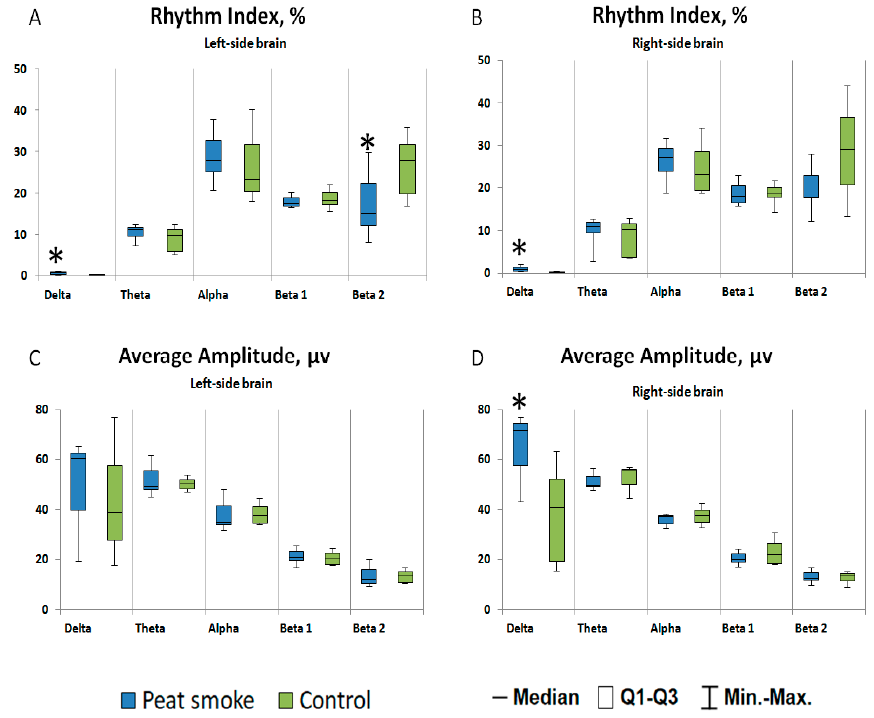
Figure 2. EEG results: rhythm indices of the left ( A ) and right ( B ) hemispheres; average amplitude of rhythms of the left ( C ) and right hemispheres ( D ). * p < 0.05.